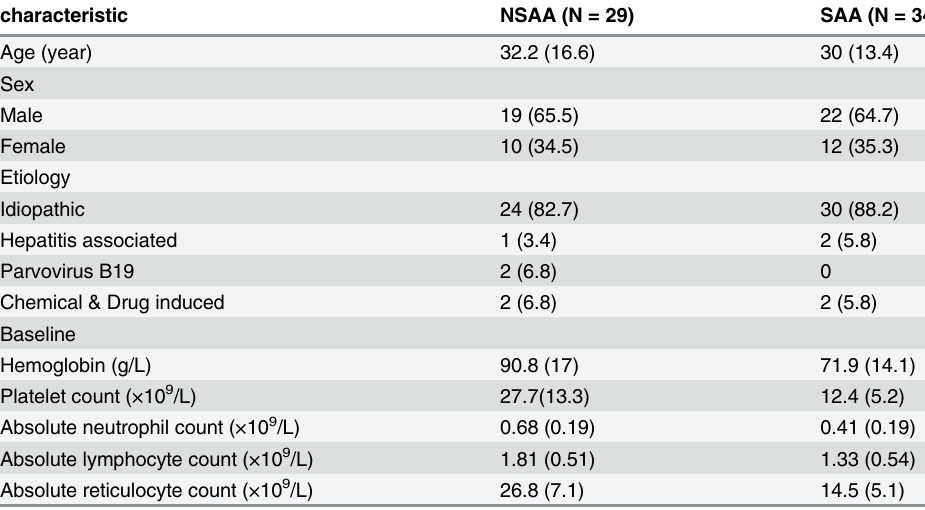
Table 1. Characteristics of studied